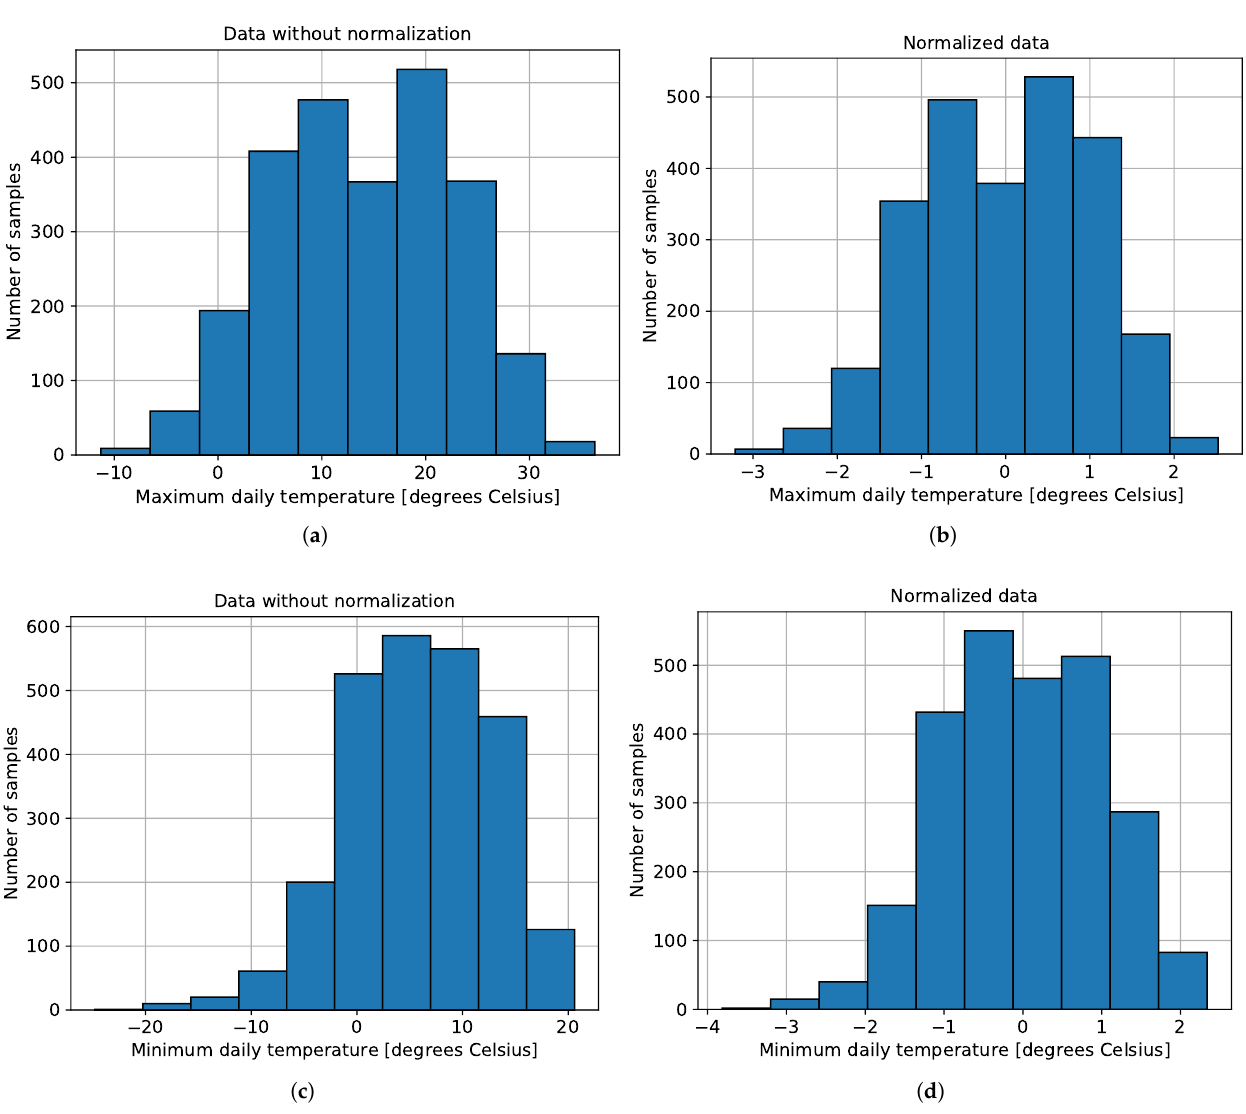
Figure A1. Input data histograms (the maximum daily temperature before ( a ) and after normalization ( b ), and minimum daily temperature) before ( c ) and after normalization ( d